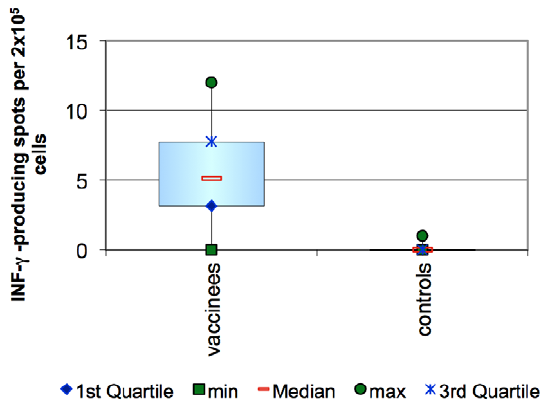
Figure 4. ELISpot detection of IFN- c secreting lymphocytes 3 weeks after the completion of the primary course. This assay detects the ability of lymphocytes to secrete IFN- c after specific stimulation with SLA by detecting spots (which represent a clone of cells secreting IFN- c ) using specific biotinylated antibodies and an automated ELISpot reader. The data presented here are the number of spots per 2 6 10 5 cells after stimulation with SLA minus the equivalent value obtained with the negative control using medium